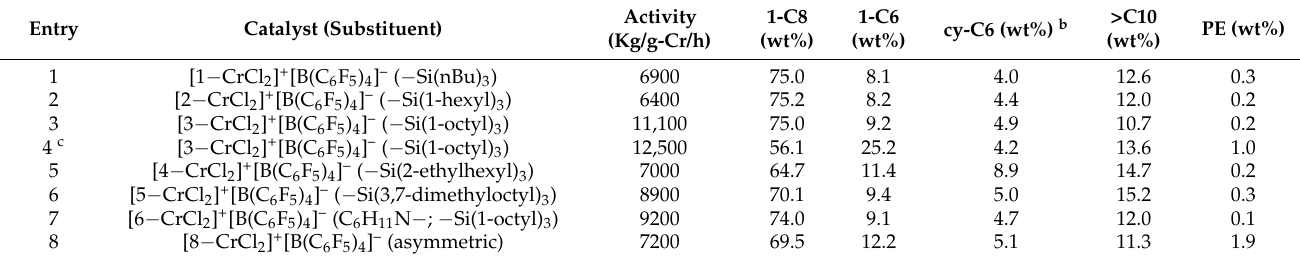
Table 1. Results for ethylene tetramerization reactions a